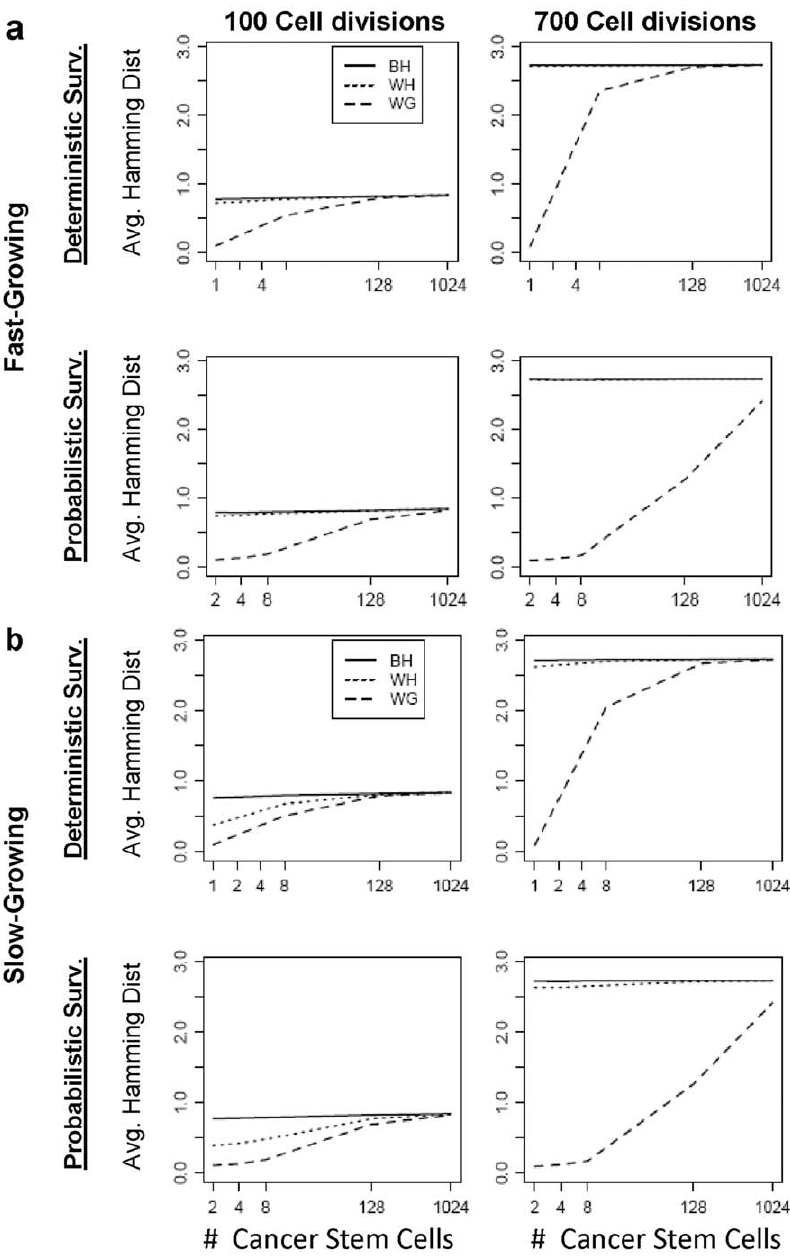
Figure 6. Mean estimate of average Hamming distance between-half (BH), within-half (WH), and within gland (WG) from a simulation study (N=10,000 replicates). Growth curve inflection time is 49 generations of cell division for fast growing tumors and 320 generations for slow-growing tumors. doi:10.1371/journal.pone.0012002.g006 undergone the same total number of cell divisions in both halves. e.g. 100 and 700 generations in the left and right half, respectively, compared to 400 generations in each half, for a total in each tumor of 800 generations. The median BH-WH difference for the tumors under asymmetric growth is 0.45 (95% simulation interval (SI) = 0.09–1.0) under 128 CSCs and 0.44 (95% SI=0.21–0.80) under 1024 CSCs. These are greater than the differences under symmetric growth (see Figure 6). Furthermore, these differences are large enough to explain the four ‘‘non-flat’’ tumors. Next we investigate the variation in within-half distances between left and right tumor halves.